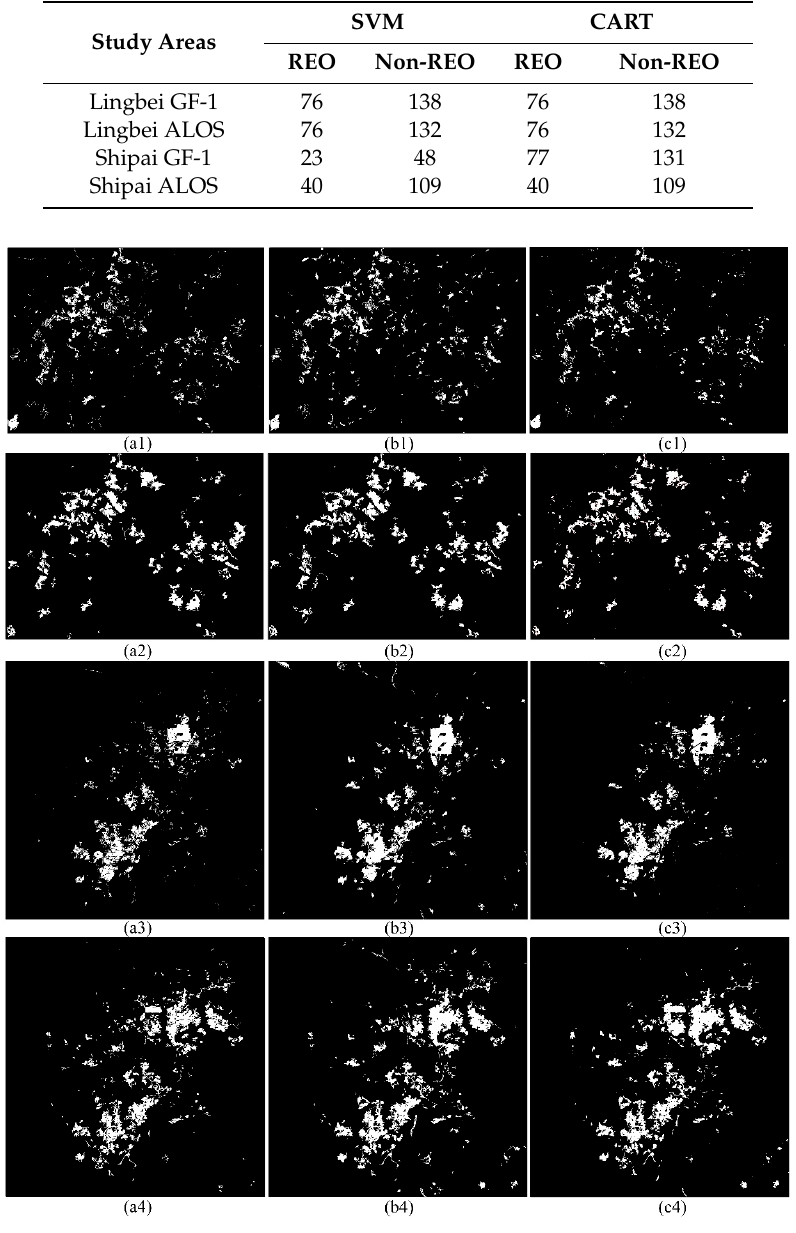
Figure 8. REO mining area extraction results with di ff erent classification algorithms. ( a1 – c1 ) Results of GF-1 images in Lingbei; ( a2 – c2 ) results of ALOS images in Lingbei; ( a3 – c3 ) results of GF-1 images in Shipai; ( a4 – c4 ) results of ALOS images in Shipai; ( a1 – a4 ) object-oriented CART; ( b1 – b4 ) object-oriented SVM; ( c1–c4 ) the improved GrabCut. Table 5. Accuracy of REO mining area extraction with different algorithms.